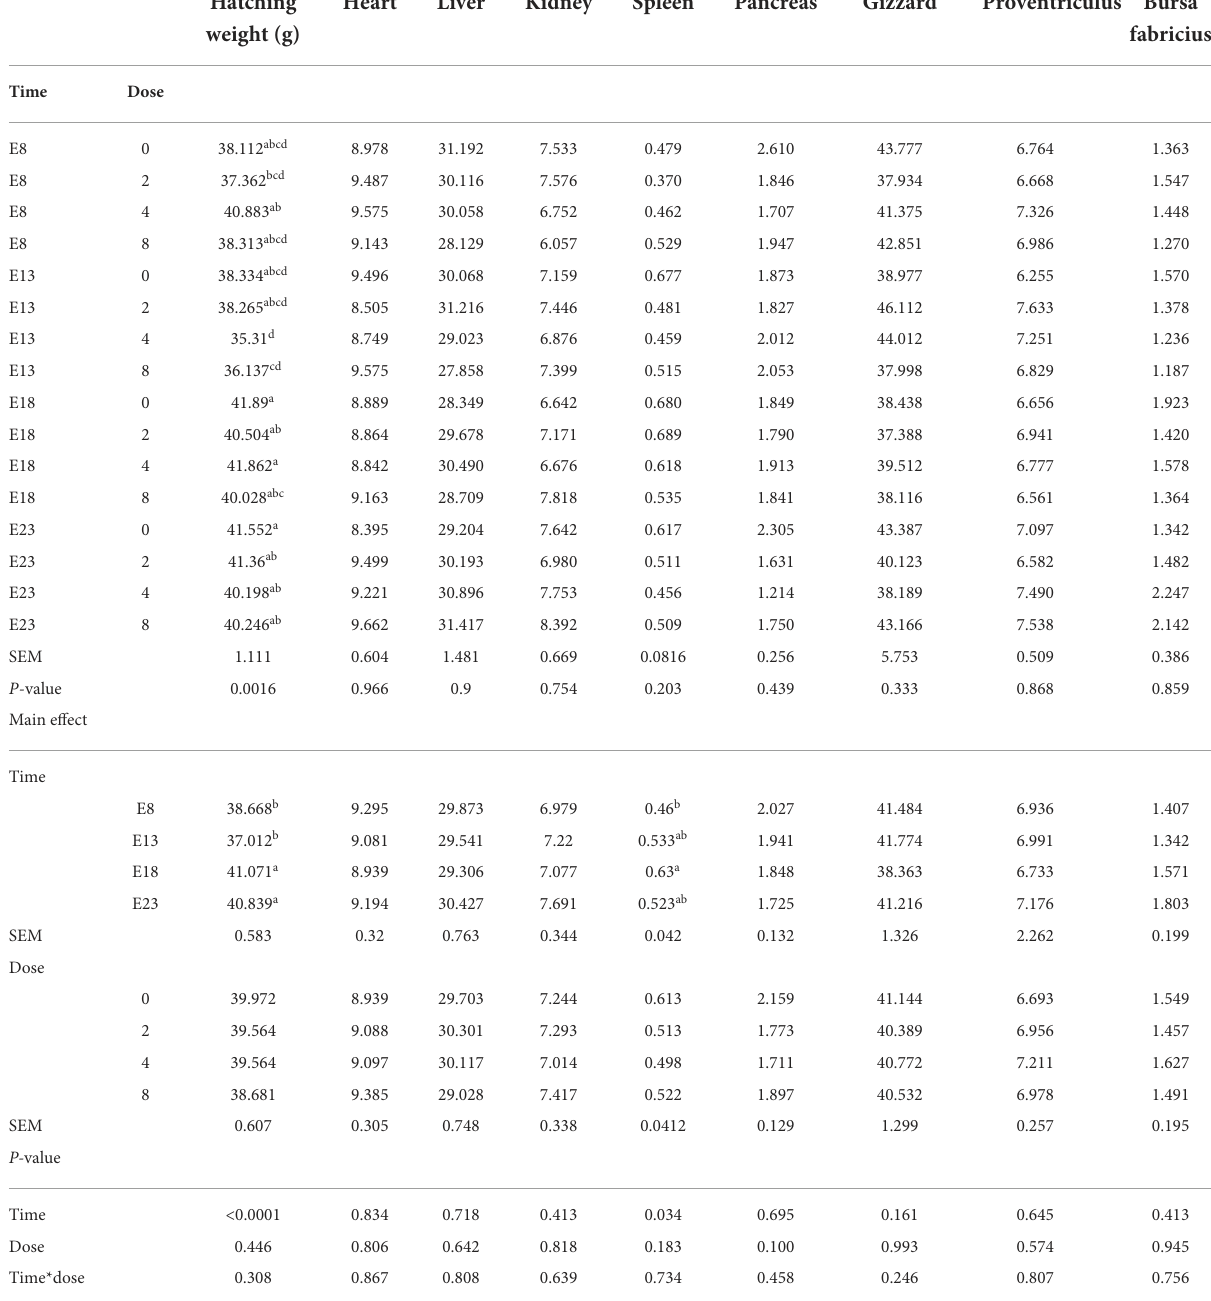
TABLE 1 Effect of time and doses of an embryo injected OTA on hatching weight and organ index of ducks at hatching 1 (g/kg).